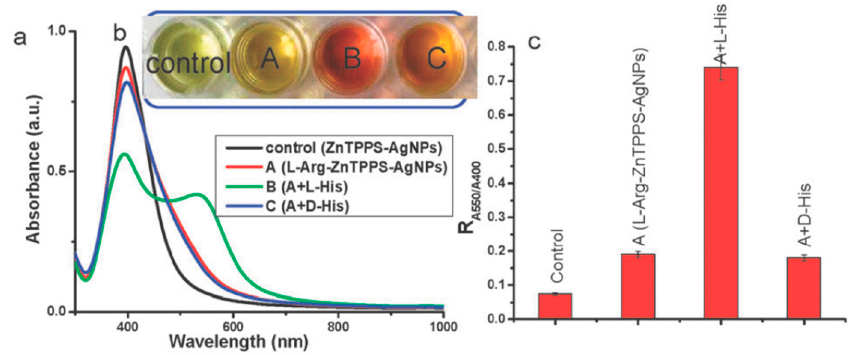
Figure 5. Schematic representation The UV-vis spectra ( a ), photographic images ( b ) and the value of R (A550/A400) ( c ) of silver nanoparticle cluster solution in the presence of D - or L -His. It is operated as follows: 0.5 mL of 1 mM solution of D - or L -His was added to 1.5 mL L -Arg-ZnTPPS-AgNPs solution and mixed for 10 min before measuring, respectively. The figure and the caption have been adapted with permission from [55], Copyright © 2012 The Royal Society of Chemistry.